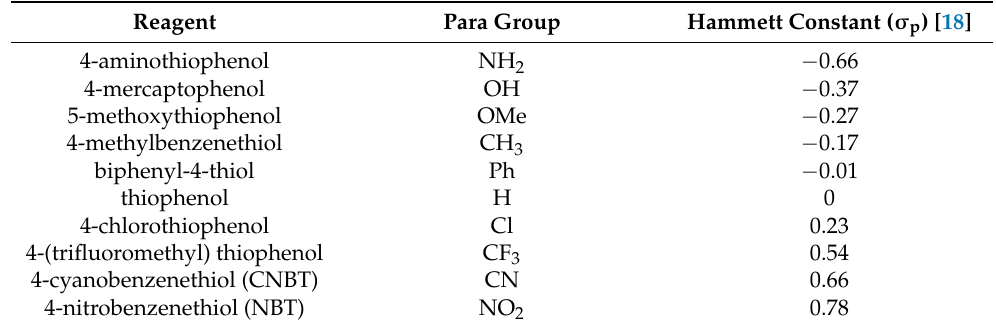
Table 1. Thiophenol compounds used, their para substituents, and respective Hammett constants. Reagent Para Group Hammett Constant ( σ p ) [18] 4-aminothiophenol NH 2 − 0.66 4-mercaptophenol OH − 0.37 5-methoxythiophenol OMe − 0.27 CH 3 −